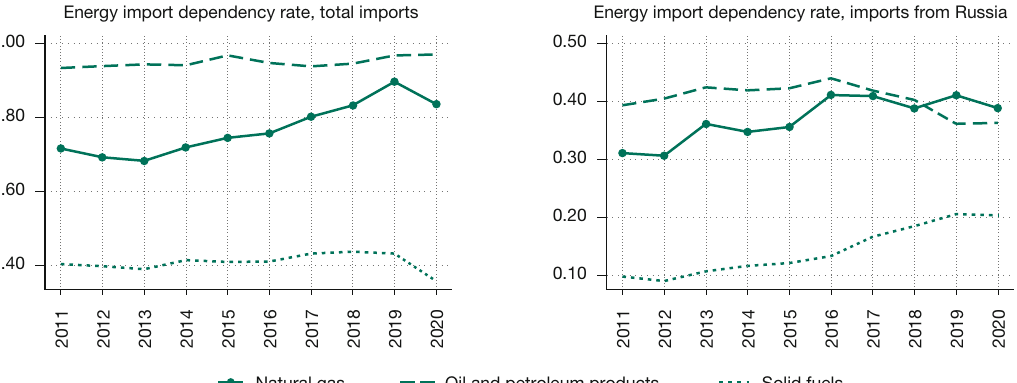
EU27 dependency on energy